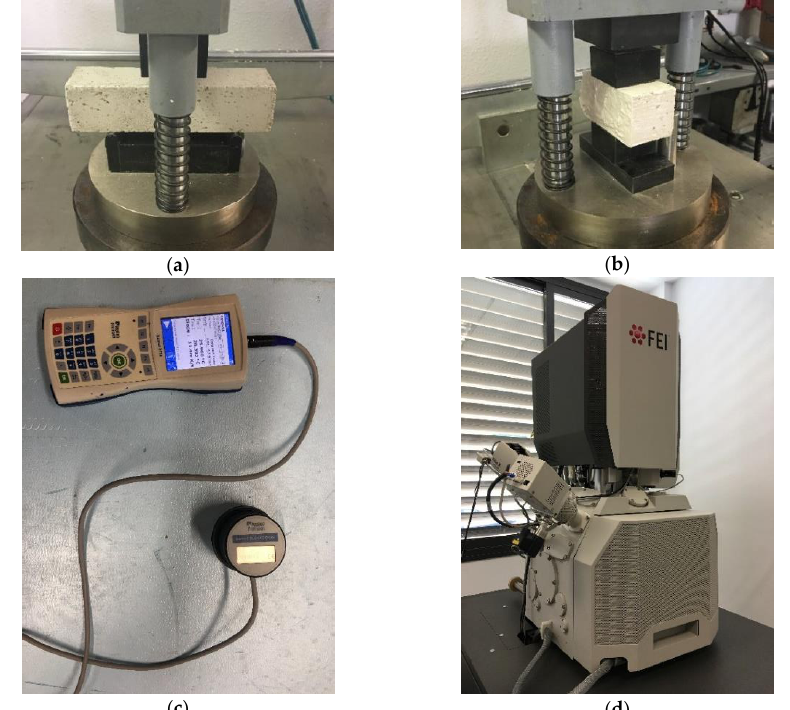
Figure 3. Test methods: ( a ) Flexural strength; ( b ) Compressive strength; ( c ) Thermal conductivity; ( d ) scanning electron microscopy